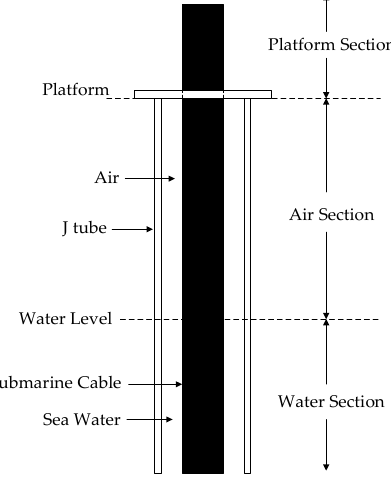
Figure 1. Diagram of a typical enclosed J-tube system [4].